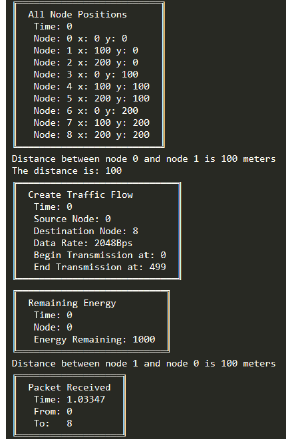
Figure 4. Transmission Power vs Distance.